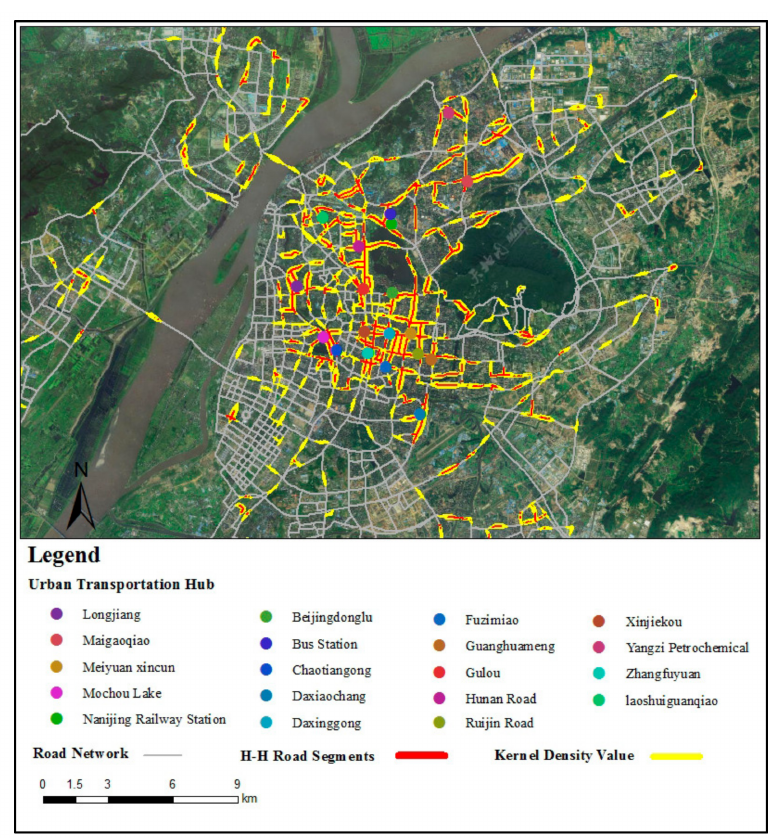
Figure 14. Network KDE results distribution and high-high road segments in